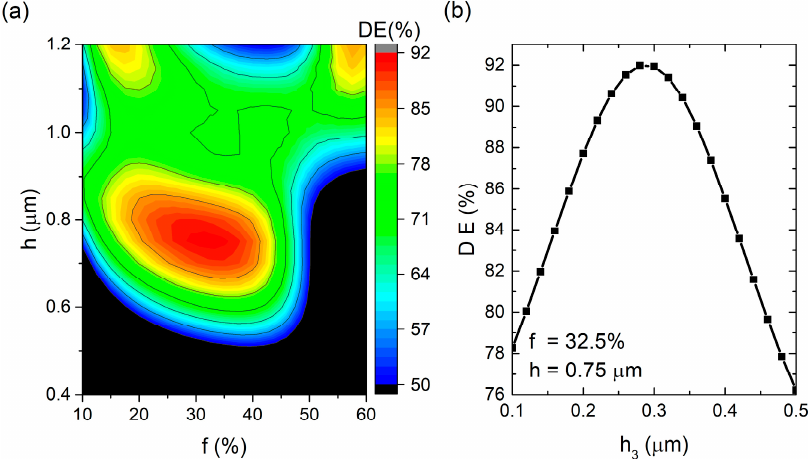
Figure 5. ( a ) Calculated GaP diffraction efficiency (DE) as a function of groove depth ℎ and filling factor 𝑓 , with h 3 = 315 nm thick NOA ARC and ( b ) Diffraction efficiency versus NOA ARC thick ‐ ness (cid:4666)ℎ (cid:2871) (cid:4667) , at 𝜆 (cid:3043) (cid:3404) 2.06 μ m, d (cid:3404) 1.7 μ m, and 3 THz phase ‐ matching frequency. ( h 3 ) , at λ p = 2.06 µ m, d = 1.7 µ m, and 3 THz phase-matching